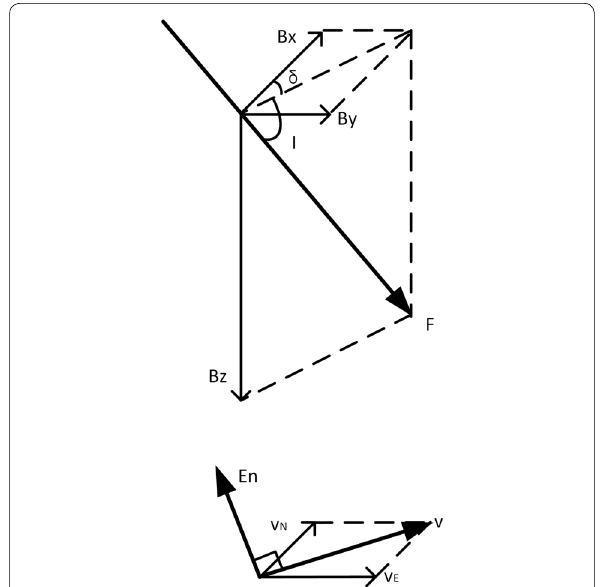
Fig. 4 A physical–mathematical model of induced EM noise from currents coupled with the Earth’s magnetic field